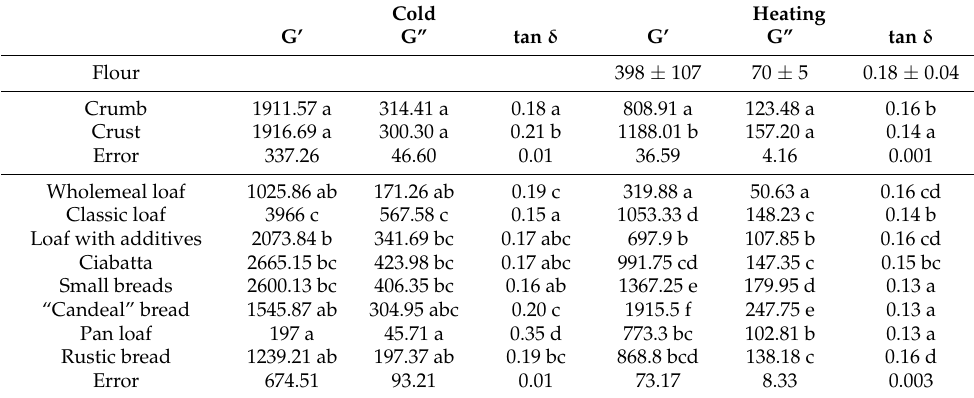
Table 4. Rheology and viscosity of